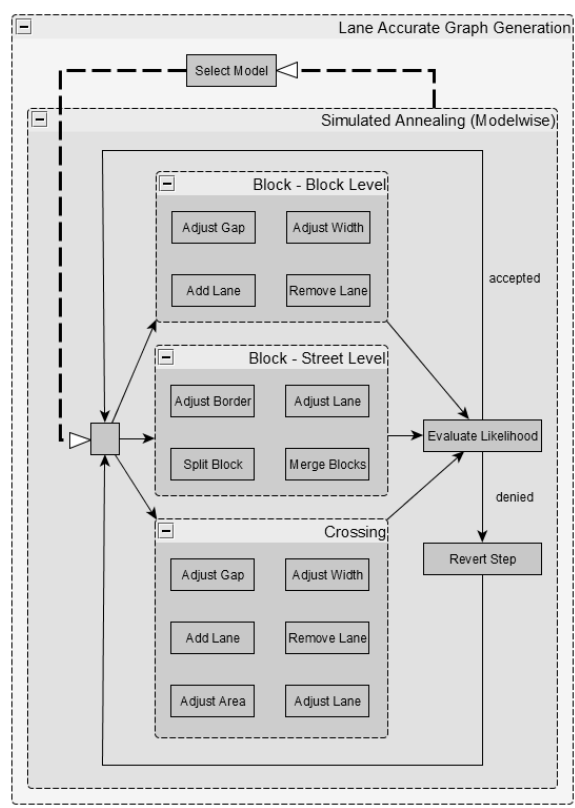
Figure 4. Abstract procedure of the optimization. In each iteration firstly the model and secondly the operation is selected. The operation add lane can add a new lane to a block on the right or left side. Thus, the state is complemented by an additional lane width. The initial lane width is sampled from a normal distribu- tion which complies with the directive of urban traffic with public bus service in accordance with (Baier et al., 2006) and applies to our urban